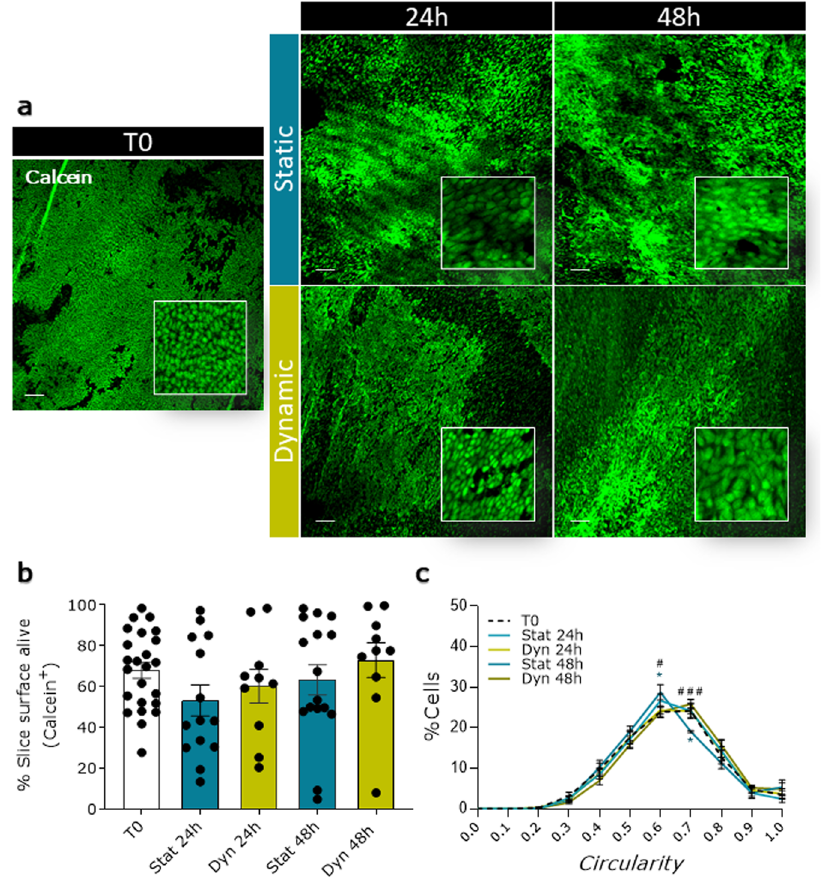
Fig. 3 Slices viability and epicardial cells morphology over culture. Cell viability in freshly cut slices (T0) and after 24 and 48 h of static (Stat) and dynamic (Dyn) culture. The epicardium maintains its morphology and viability upon culture ( a ), as quanti fi ed by the average percentage of the calcein AM positive area ( b ) N of pigs = 6 – 18, number of slices displayed in the graph. Epicardial cells circularity distribution ( c ). N of pigs = 3 – 5, number of slices: T0 = 8, Stat 24 h = 5, Dyn 24 h = 6, Stat 48 h = 5, Dyn 48 h = 7. All graphs display data as mean ± SEM. * p ≤ 0.05 vs T0, # p ≤ 0.05 Stat 48 h vs. Dyn 48 h, ### p ≤ 0.001 Stat 48 h vs. Dyn 48 h. Scale bar, 100